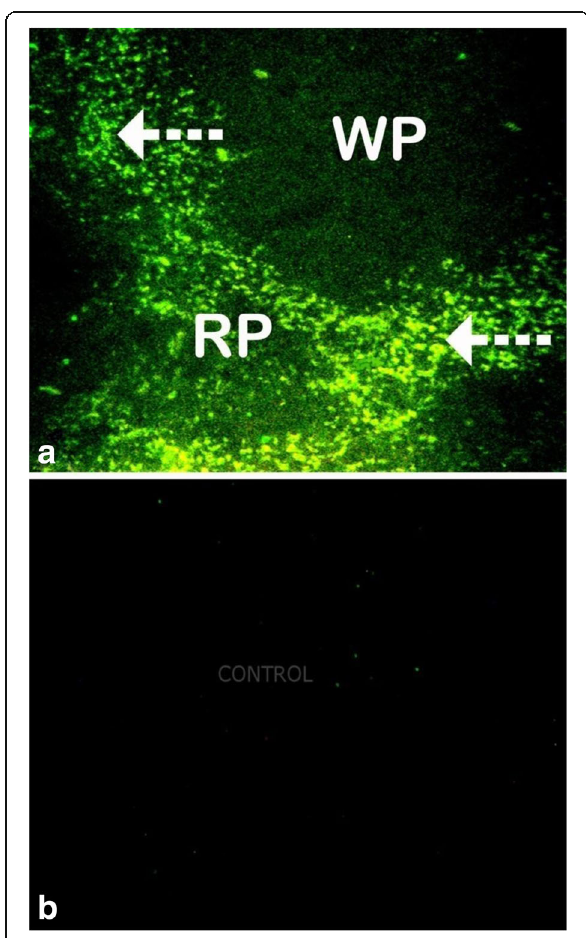
Fig. 12 Immunohistochemical images of the spleen section, from mice treated with TME at the rate of 1500 mg/kg, 8 hourly intervals for three days consecutively. Immunoreactivity labeling indicative of apoptotic cells ( white arrows ) largely seen at the periphery of the white pulp and extends in the red pulp in ( a ). Some cells positive for ssDNA immunoreactivity are also seen in the white pulp in ( b ). Magnifications, ( a & b )